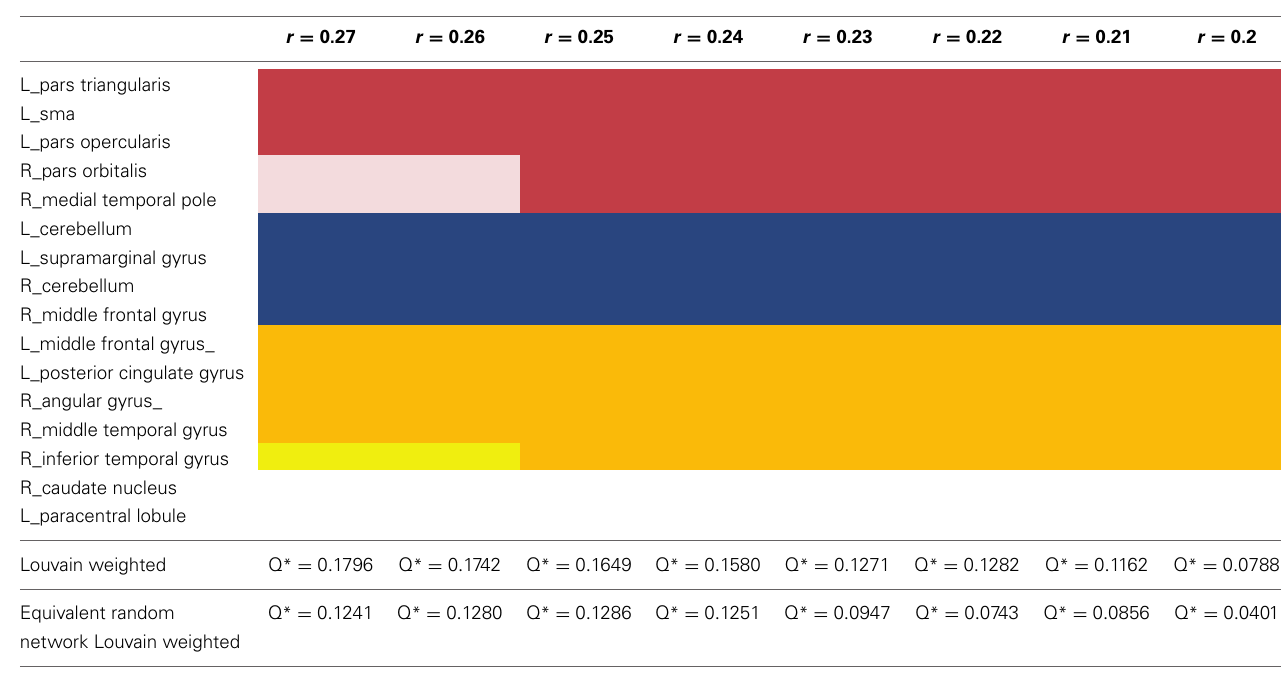
Table 2 | Illustrating the result of the modularity analysis over the investigated threshold.